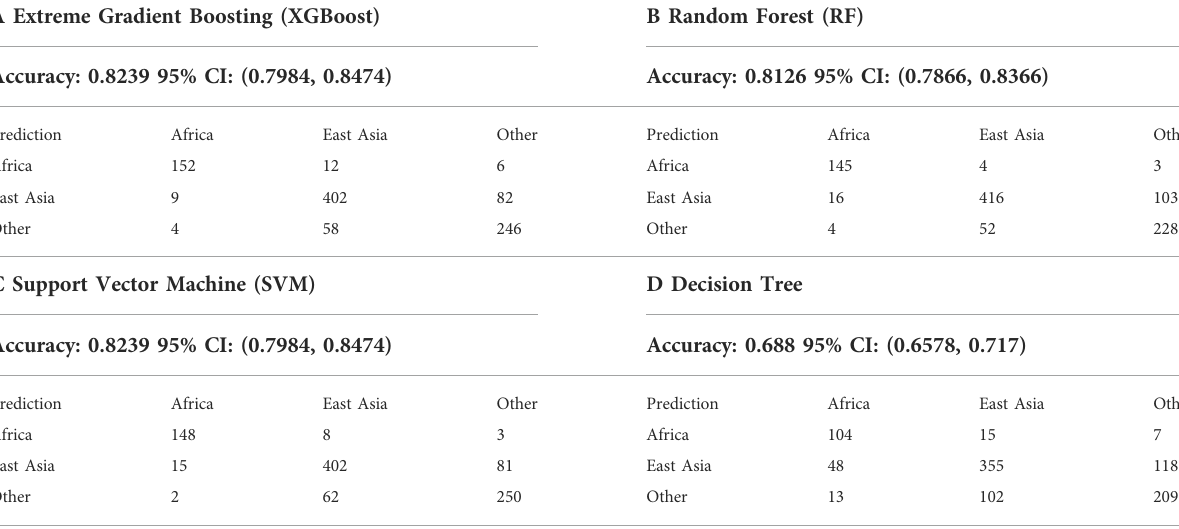
TABLE 2 The accuracies and 95% CI values of four arti fi cial intelligence (AI) models including the XGBoost (A), RF (B), KVM (C) and decision tree (D) as for the biogeographical ancestor prediction. A Extreme Gradient Boosting (XGBoost) B Random Forest